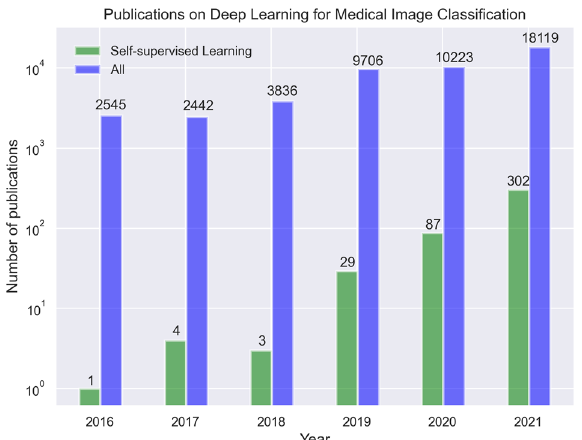
Fig. 1 Timeline showing the number of publications on deep learning for medical image classi fi cation per year, found by using the same search criteria on PubMed, Scopus and, ArXiv. The fi gure shows that self-supervised learning is a rapidly growing subset of deep learning for medical imaging literature.